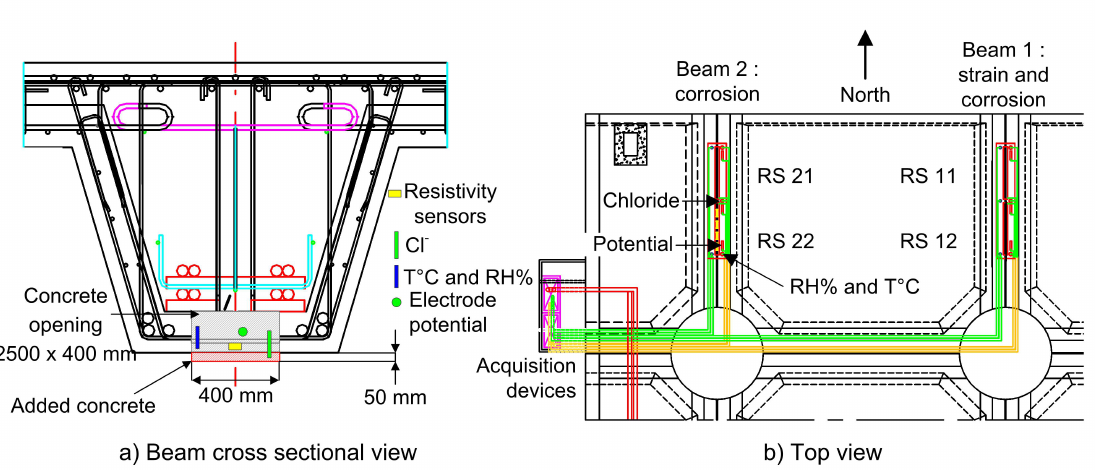
Figure 4. Location of potential, chloride and resistivity sensors (referenced RS